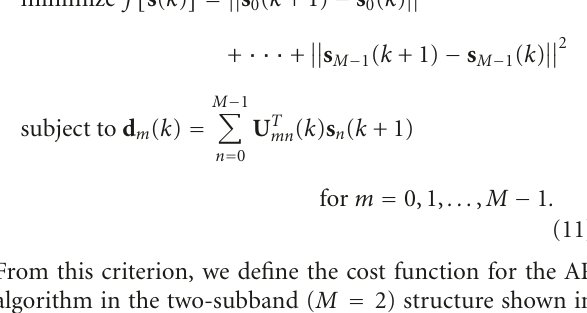
Figure 3: System identification model for two-subband adaptive fil-